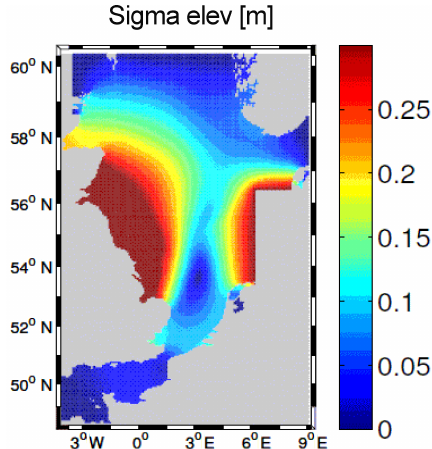
Figure 13. Impact of the coastal boundary condition of a nested model on the North Sea dynamics. The figure originates from Schulz-Stellenfleth and Stanev (2016, with permission from Else- vier) and shows the standard deviation of elevation resulting from fully correlated perturbations with SD 0.3m along the German Bight